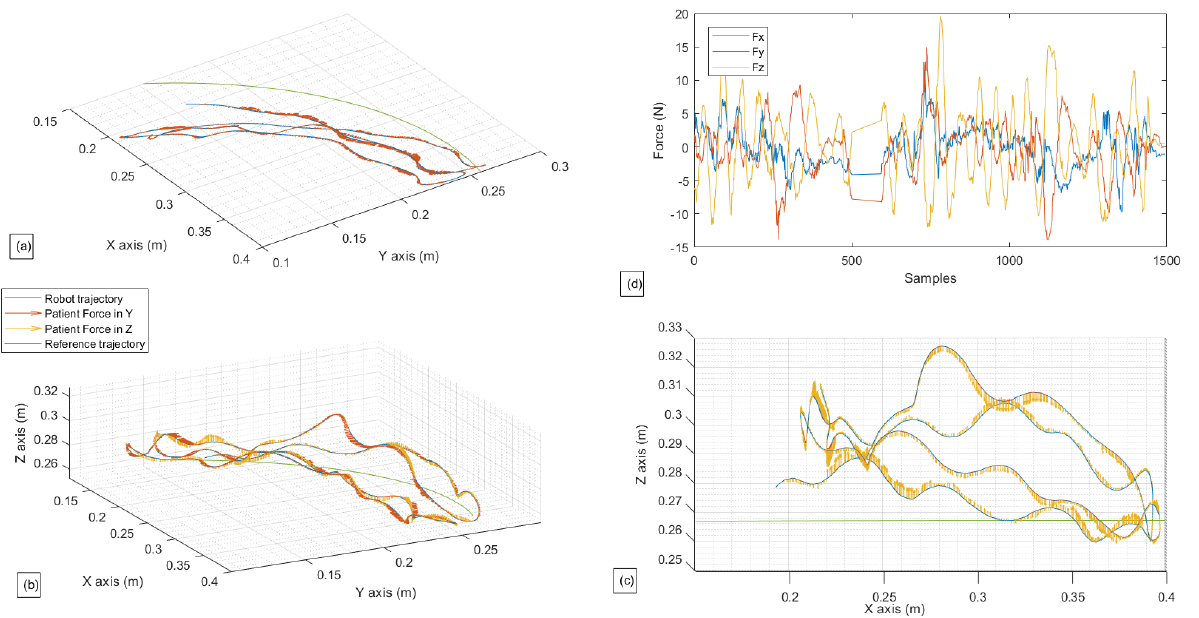
Figure 13. Experimental test for a free Active-Assisted lateral shoulder rotation. ( a ) Robot path performed in contrast with the reference path in ( x , y ) . ( b ) Robot path performed in contrast with the reference path in ( x , y , z ) . ( c ) Robot path performed in contrast with the reference path in ( x , z ) . ( d ) Forces gathered by the Robotiq sensor in ( x , y , z ) in relations with the samples.